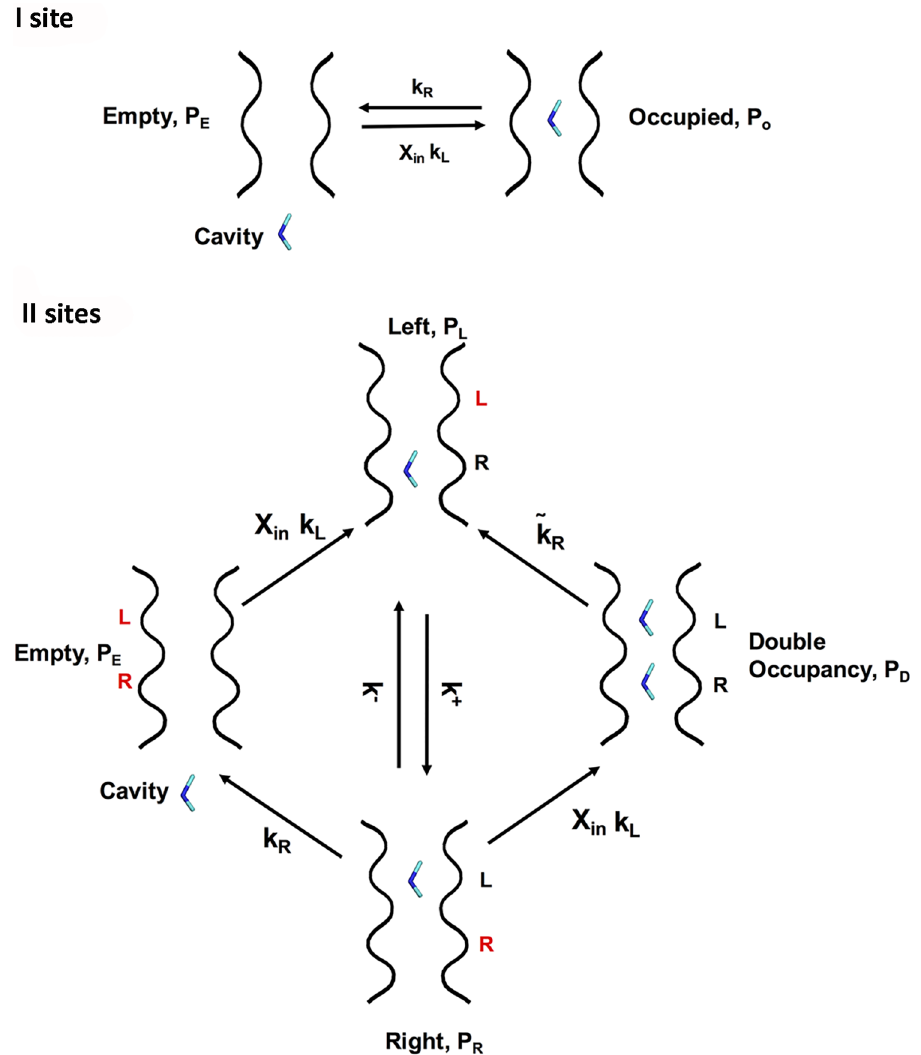
Fig 5. Model for the DMA permeation through the CNGA1 channel. The first scheme (I site) describes a simple model of DMA permeation in which there is a single binding site, while the second scheme (II sites) depicts a different scenario with the CNGA1 channel occupied simultaneously by two ions referred to as right (R) and left (L). P E is the probability that the channel is empty, P O refers to the channel occupied; P L is the probability that the channel is occupied in the left site, P R is occupied in the right side, P D when the channel is occupied by two ions. k L is the rate for the transition in which the ion enters into the channel, while k R for the transition in which the ion leaves the channel crossing the barrier towards the right. The rate e k is associated to a transition between the state with the Double R Occupancy and the state with a single ion in the Left side. k + is the transition rate from the binding site at the left to that at the right and k - is the corresponding reverse rate. The transition rates k R , k L , k + and k - are estimated from the Free Energy profile computed with a single DMA inside the pore (see right panel in Fig 3A) and the transition rate e k R is estimated from the Free Energy profile computed with a second DMA inside the pore (see right panel in Fig